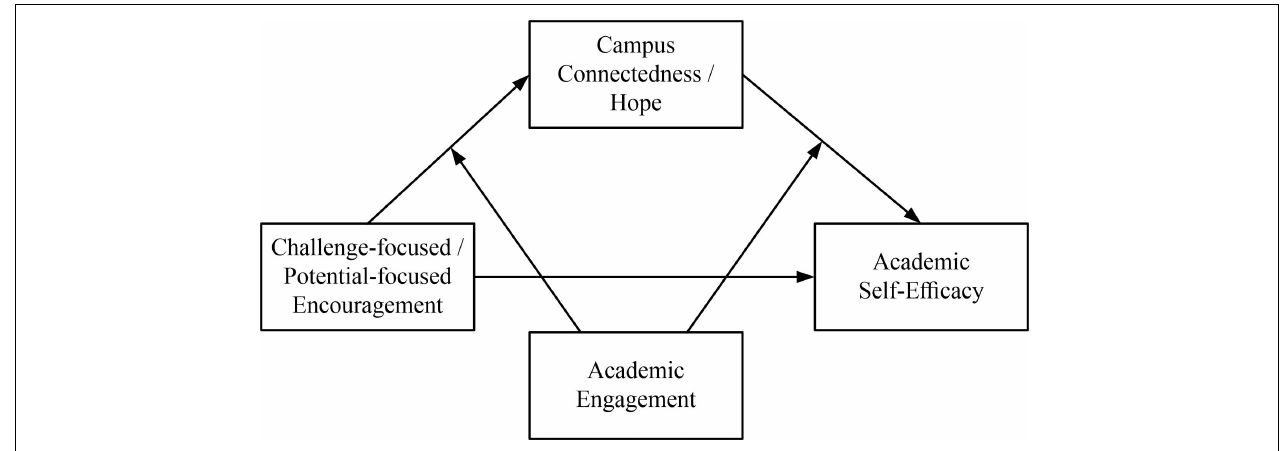
FIGURE 1 | Theoretical model